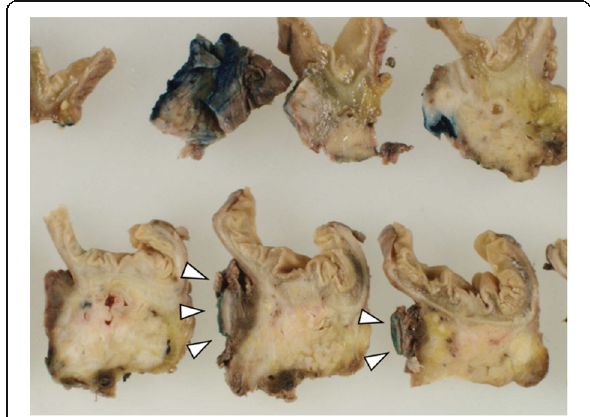
Fig. 9 Macroscopic findings of resected specimen of case